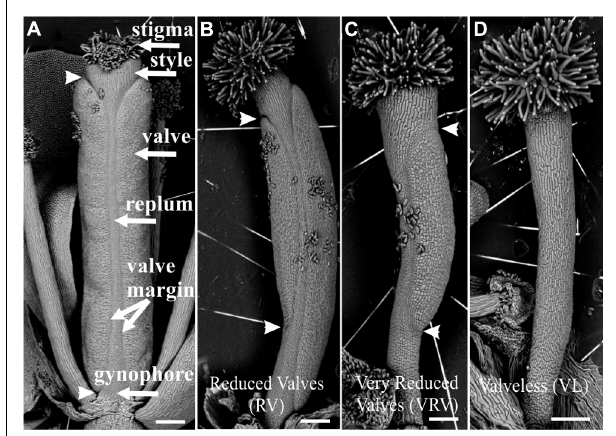
FIGURE 1 | Scanning electron micrographs of classification of apical-basal phenotypes in the Arabidopsis gynoecium. (A) Mock-treated wild type gynoecium. (B) Gynoecium presenting a “ReducedValves” (RV) phenotype. (C) Gynoecium with the “Very Reduced Valves” (VRV) phenotype. (D) Gynoecium with the “Valveless” (VL) phenotype.These gynoecia were treated with NPA.The arrowheads indicate the beginning and the end of valves. Scale bars: (A–D) 200 μ m.